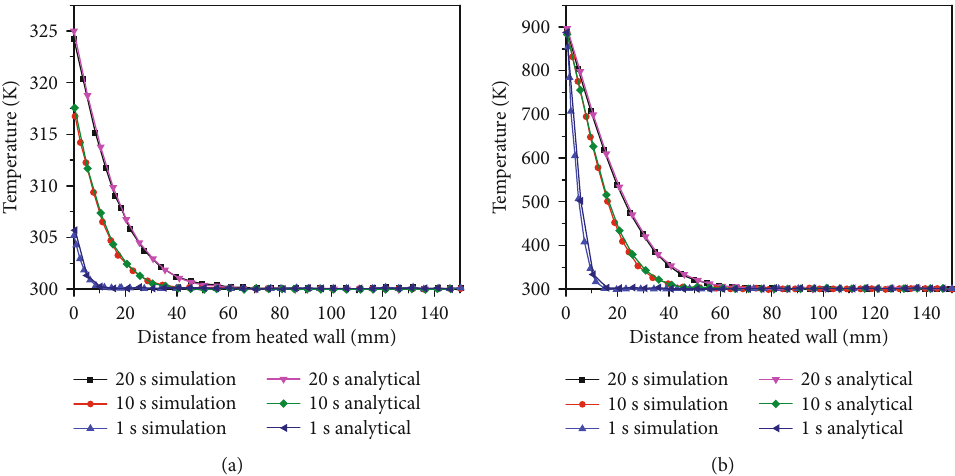
Figure 5: Temperature distribution of the semi-in fi nite plate with constant temperature (a) and constant heat fl ux (b).